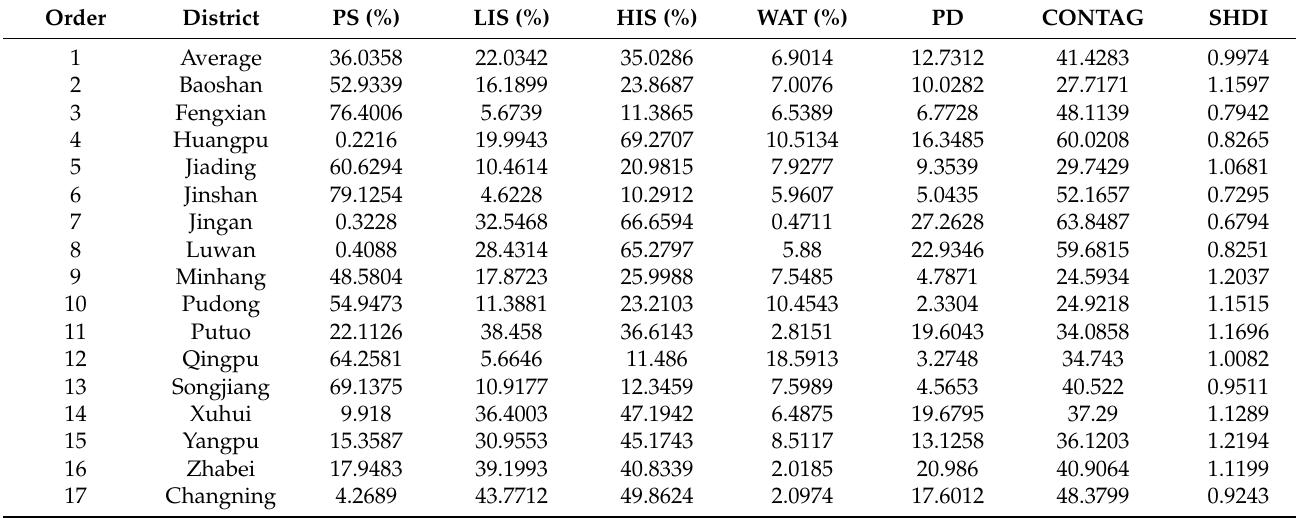
Table 3. The landscape metrics of impervious surfaces in each district of Shanghai